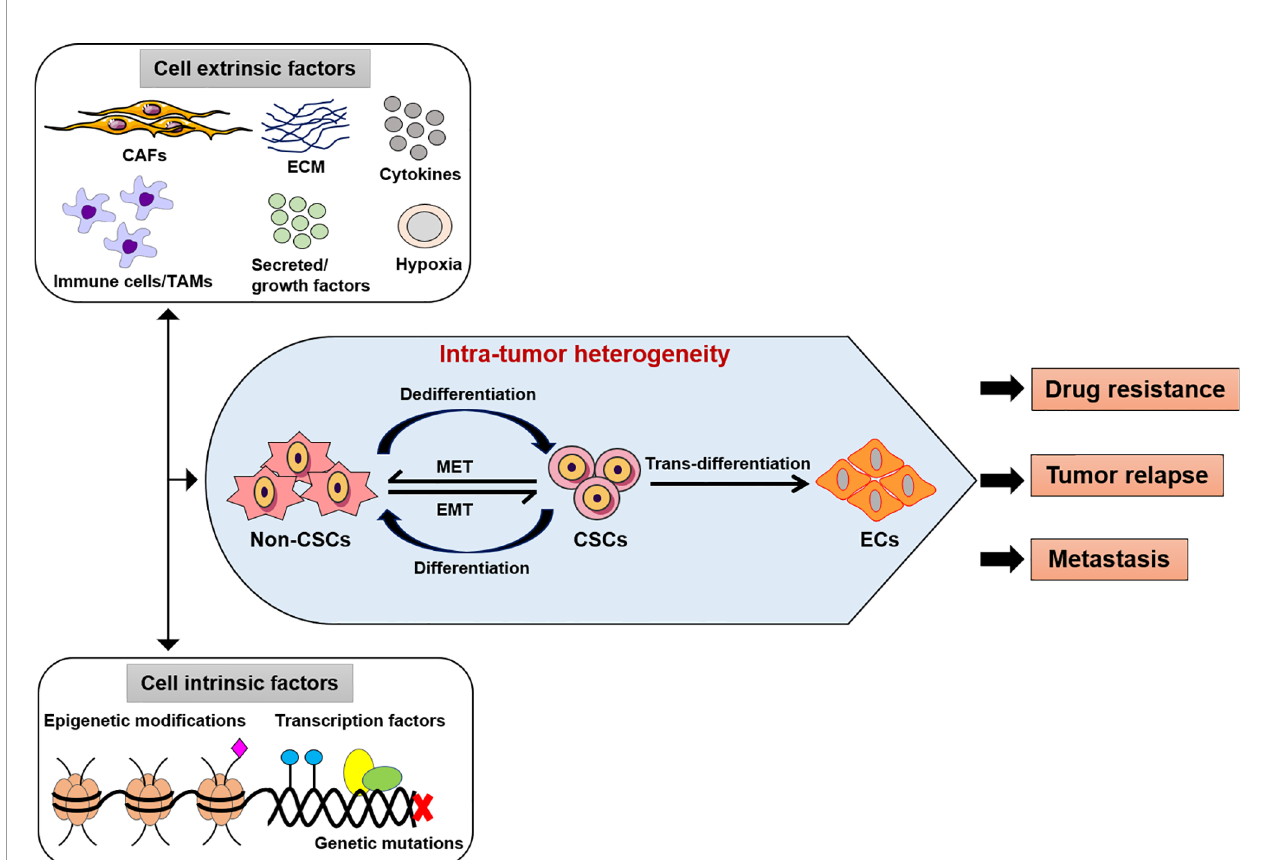
FIGURE 1 | Intra-tumor heterogeneity by extrinsic or intrinsic factors. The modi fi cations of cancer cells such as genetic, epigenetic alterations, and microenvironment perturbations. CSCs show an induced EMT system, which mostly exhibit an intermediate condition. This activity depends on both genetic mutations, epigenetic alterations, and transcriptional modi fi cation of cancer cells and signals provided by TME (CAFs or TAMs, immune cells, ECM, cytokines, secreted or growth factors). Thus, the intra-tumor heterogeneity might be play a potential role in the development of effective therapeutic approaches as drug resistance, tumor relapse and metastasis. CSCs, cancer stem-like cells; EMT, epithelial-to-mesenchymal transition; MET, mesenchymal-to-epithelial transition; ECs, endothelial-like cells, CAFs, cancer-associated fi broblasts; TAMs, tumor-associated macrophages; ECM, extracellular